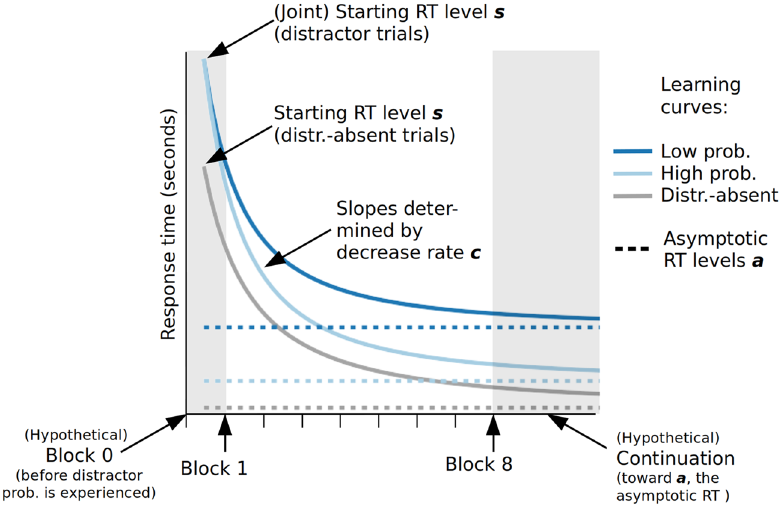
contribute to explaining the data. Hence, for the subsequent parameter estimation we conservatively employed the most general model (i.e., the “both-effects model”) that allows for differences in both, the asymptotic RT levels and the decrease rates. Figure 6 depicts the estimated learning curves (Fig. 6a, d), the group-level parameter estimates (Fig. 6b, e), and relative parameter differences to the distractor-absent baseline (Fig. 6c, f). We first report the modes of the group-level posterior distributions of the between-task differences (exem- plarily for the distractor-absent baseline) and their 95% Highest Posterior Density (HPD) intervals in square brackets. These differences are not shown explicitly in Fig. 6. As mentioned earlier, the overall response times were faster in the fixed-feature task compared to the mixed-feature task. Visually, these differences between tasks manifest in the different vertical levels in which the learning curves reside when comparing Fig. 6a, d. The curves from the fixed-feature task reside at substantially lower levels than the ones from the mixed-feature task. This is reflected in the different starting RT levels s ( (cid:31) s absent between = s absent mixed − s absent fixed = 320 ms [110, 590] ) and asymptotic RT levels a ( (cid:31) a absent between = a absent mixed − a absent fixed = 76 ms [47, 98] ) between tasks. Both lie far from zero in the positive range, indicating substantially smaller starting and asymptotic RTs in the fixed-feature task. Second, we turn to the differences in the asymptotic RT levels and the decrease rates relative to the baseline within each task (calculated at the participant level). In the fixed-feature task, the asymptotic distractor cost in the low-probability condition was estimated at = a low − a absent = 40 ms [28, 53] (cf. Fig. 6c, upper left panel). In the high-probability condition, (cid:31) a low fixed fixed fixed high = a high − a absent = 12 ms [1.6, 23] (cf. the asymptotic distractor cost was substantially smaller with (cid:31) a fixed fixed fixed Fig. 6c, lower left panel). Turning to the decrease rates c , the difference in decrease rates between the distractor- absent baseline and both the low- and high-probability conditions was estimated at similar magnitudes with = c low − c absent = 0.16[ − 0.44, 0.84] and (cid:31) c high = c high − c absent = 0.13[ − 0.45, 0.69] ; indicating faster (cid:31) c low fixed fixed fixed fixed fixed fixed approach to their asymptotes than in the baseline (cf. Fig. 6c, right panels). low = a low − a absent = In the mixed-feature task, the asymptotic distractor cost was large with (cid:31) a mixed mixed mixed 68 ms [45, 92] in the low-probability condition whereas it was much smaller in the high-probability condition high 12 ms [ − 7.5, 32] ) (cf. Fig. 6f, left panels). ( (cid:31) a mixed difference estimated at The difference in decrease rates was estimated at (cid:31) c low mixed = c low mixed − c absent mixed = 0.4[ − 0.12, 0.96] in the low- probability condition (cf. Fig. 6f, upper right panel), reflecting a higher decrease rate difference as in the fixed- high − c absent = 0.11[ − 0.33, 0.54] (cf. c high feature task. In the high-probability condition, (cid:31) c mixed was estimated at mixed mixed Fig. 6f, lower right panel), reflecting a similar decrease rate difference as in the fixed-feature task. Reports of distractor location regularity. 30% of the participants in the fixed-feature task and 20% in the mixed-feature task reported noticing regularities in distractor location. The probability with which these participants indicated the correct high-probability location was about chance level (11.11% fixed-feature task, 16.6% mixed-feature task).